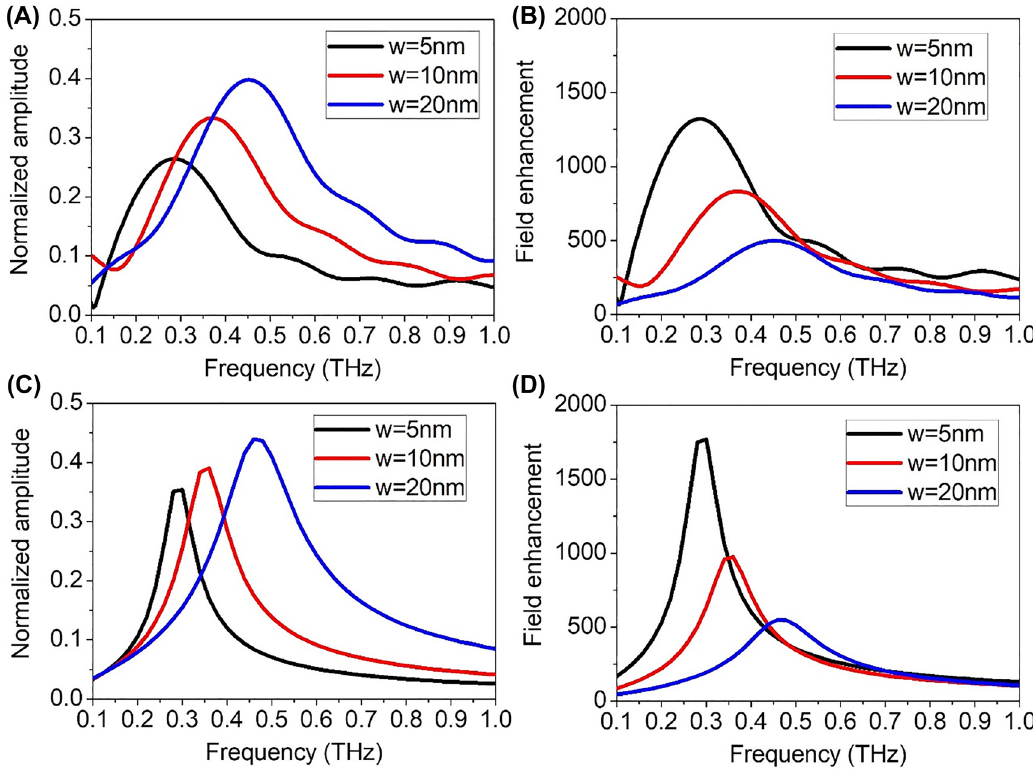
Figure 3: Transmitted electric field amplitude spectra of nanotrenches with various gap widths. (A) Measured transmittance spectra for 5, 10, and 20 nm-wide nanotrench samples. Each spectrum is normalized with respect to transmittance of bare glass substrate. (B) Field enhancement factors at the gap exit retrieved from experimental data using Kirchhoff integral formalism. (C) Calculated values for normalized transmittance, and (D) corresponding field enhancement factors.